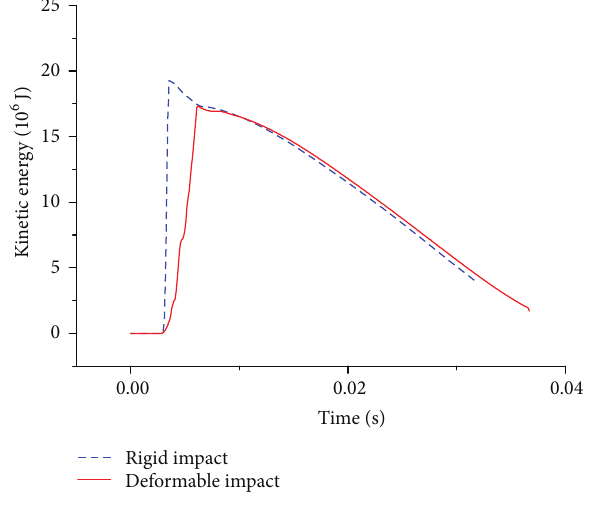
Figure 11: Kinetic energy of C1 segment.